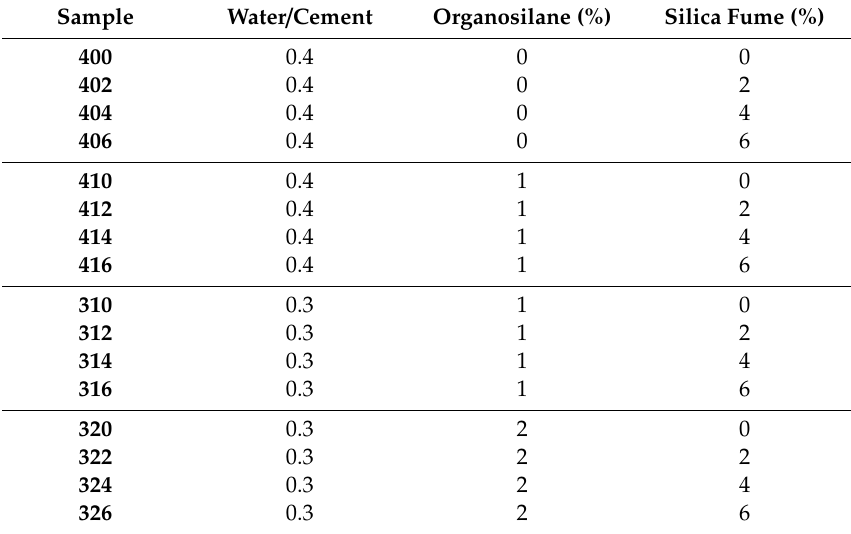
Table 1. Recipes for the samples investigated in the present study.